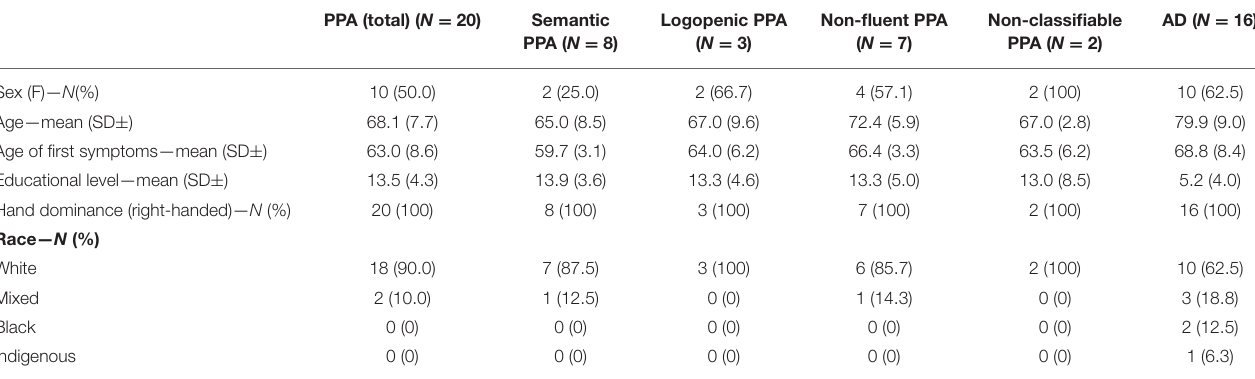
TABLE 1 | Sociodemographic characteristics of the